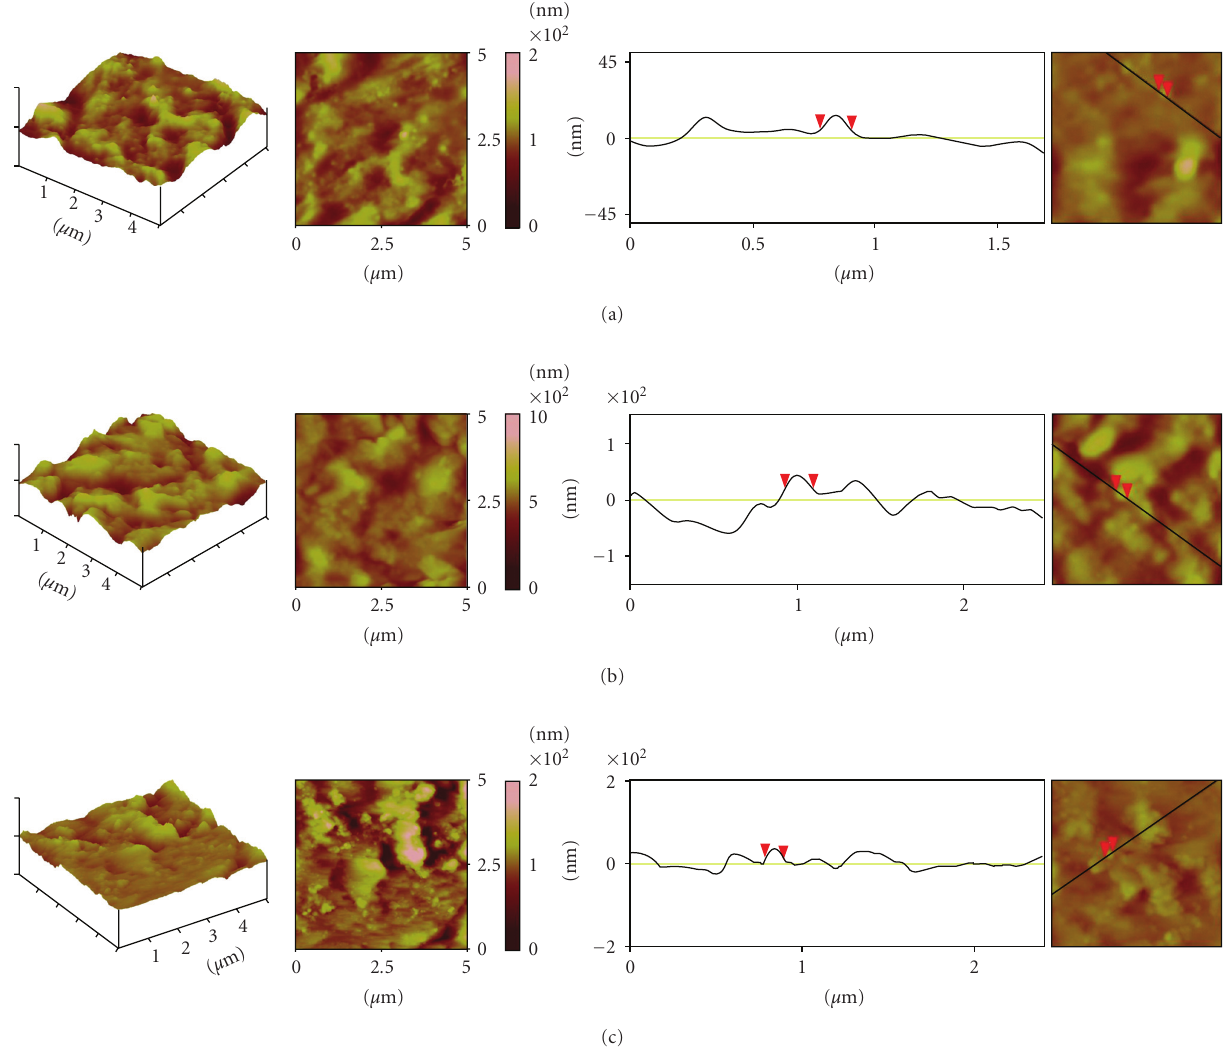
Figure 57: (a) 3D and 2D AFM images of irradiated L-threonine at 1 × 10 10 ions/cm 2 . (b) 3D and 2D AFM images of irradiated L-threonine at 1 × 10 11 ions/cm 2 , (c) 3D and 2D AFM images of irradiated L-threonine at 1 × 10 12 ions/cm 2